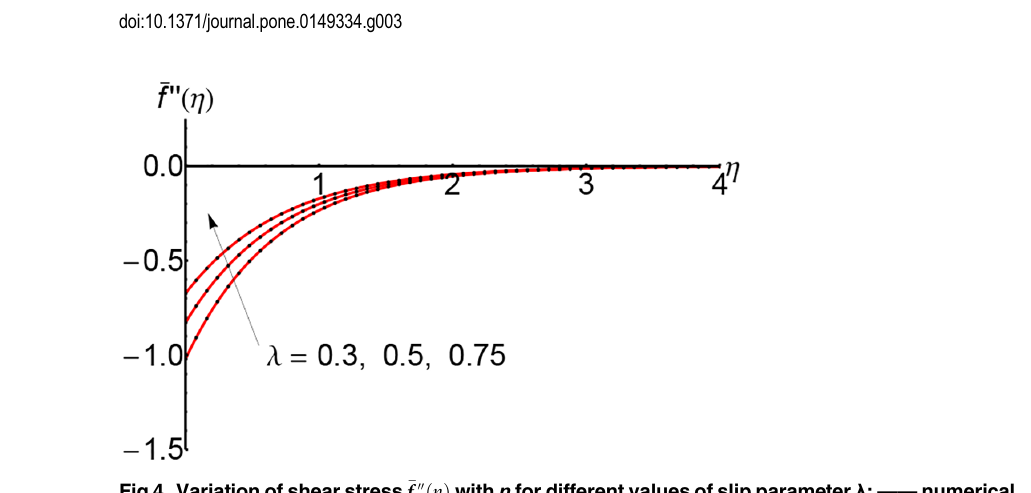
PLOS ONE | DOI:10.1371/journal.pone.0149334 March 31,